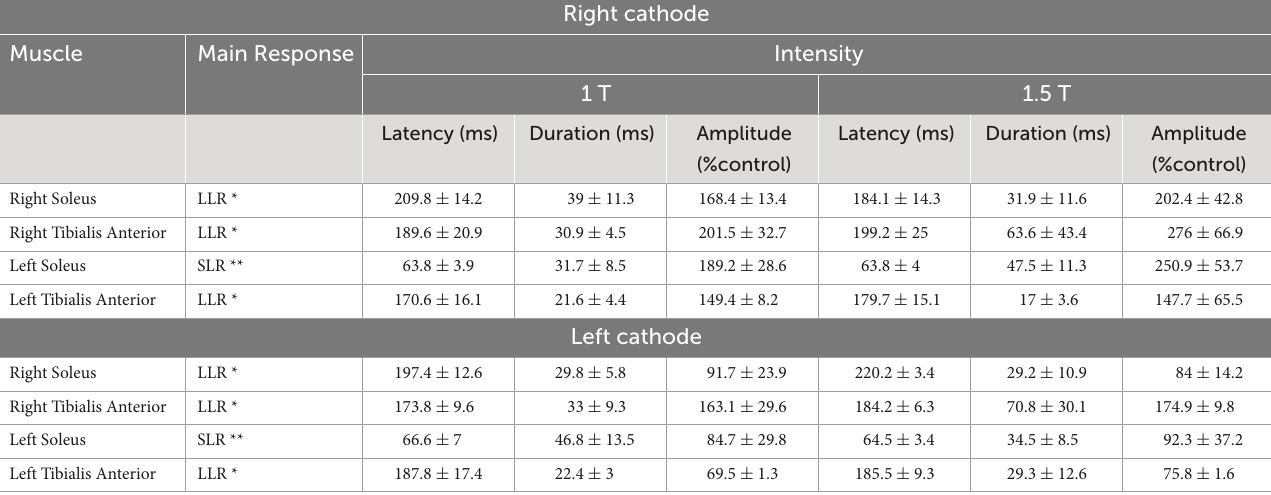
TABLE 1 EMG responses in left and right SOL and TA evoked by RCathode and LCathode configurations. Right cathode Muscle Main Response